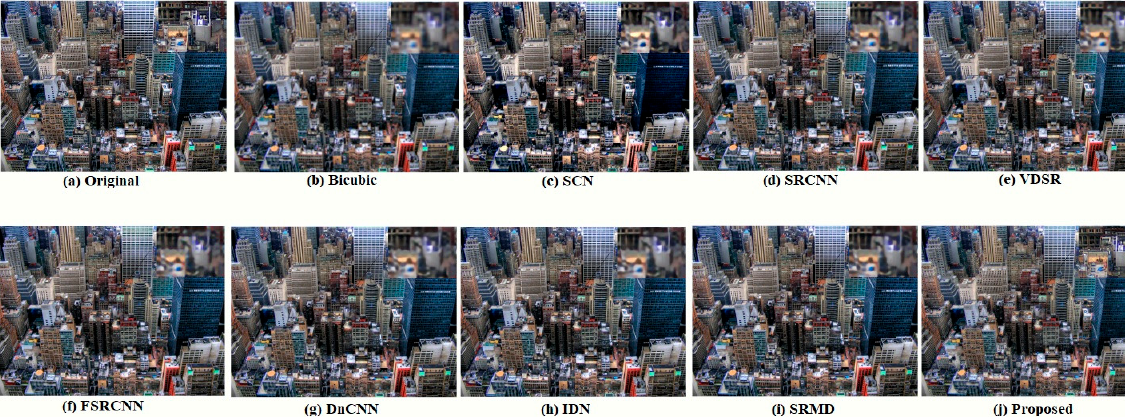
Figure 11. Visual comparison for the Urban73 image at the scale-up factor of 4.